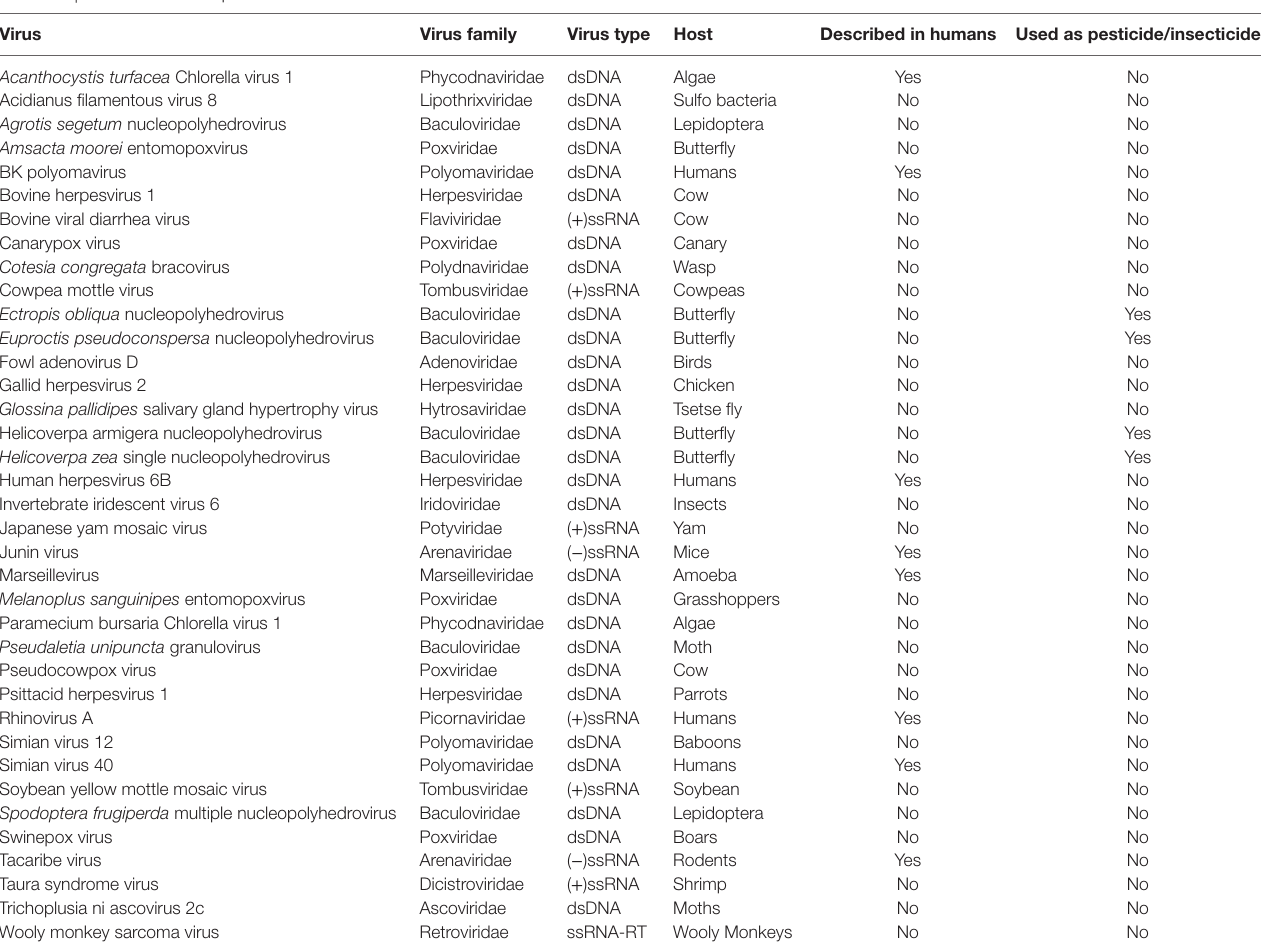
Table 1 | Breakdown of unique